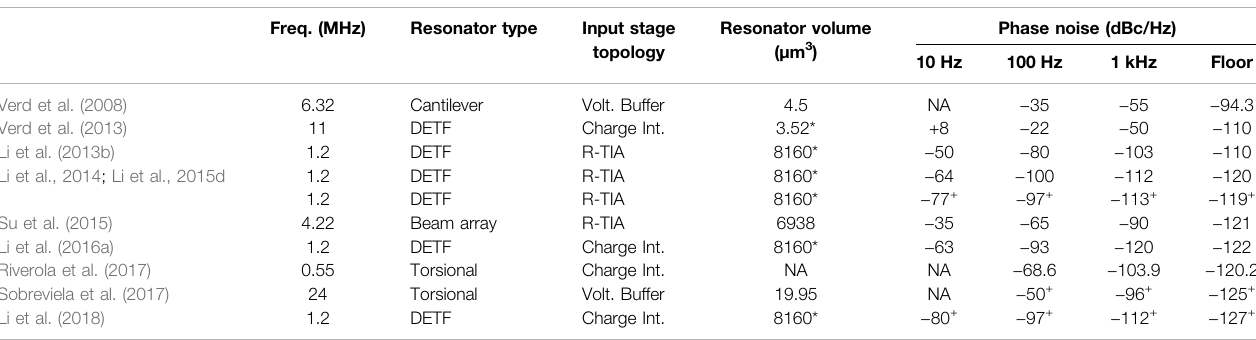
TABLE 1 | Phase noise